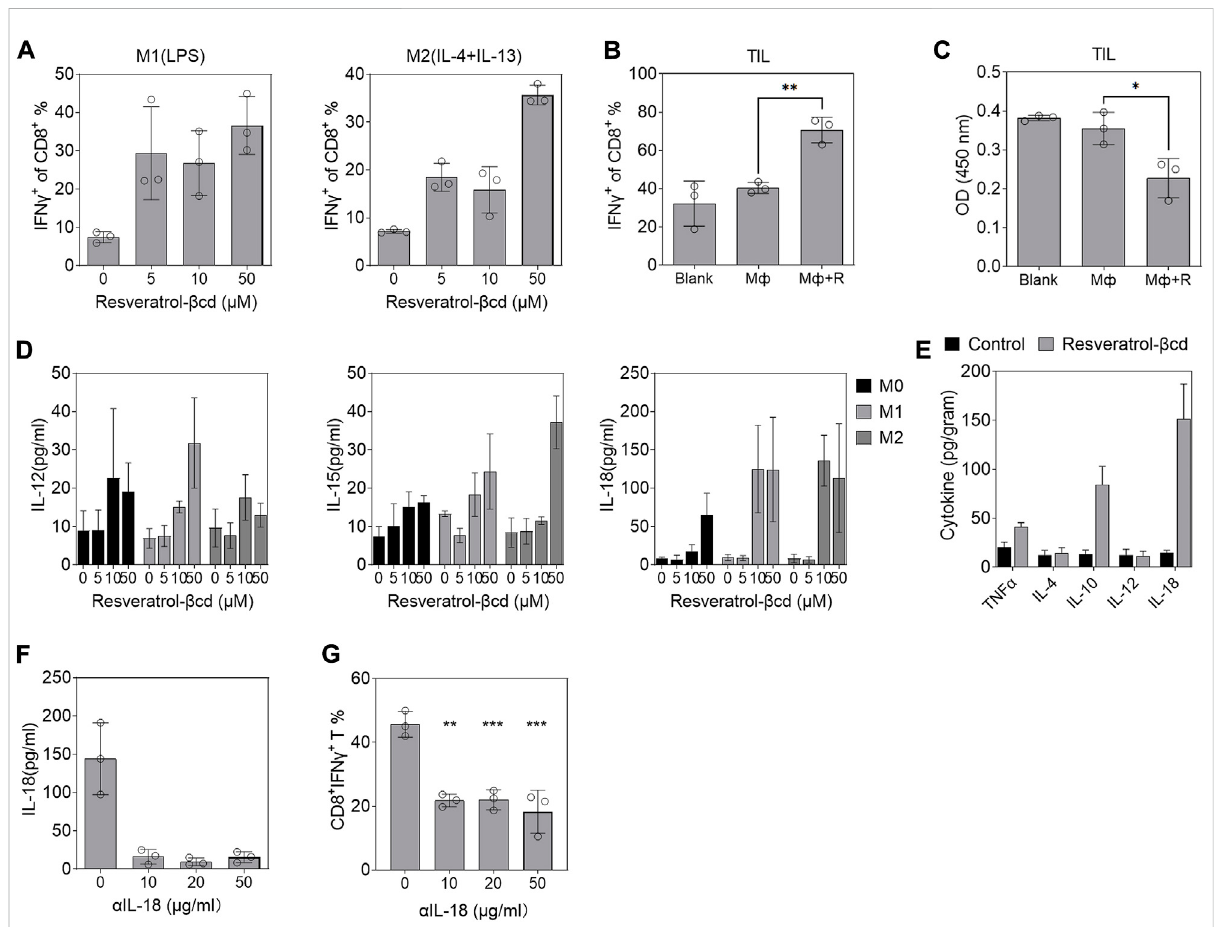
FIGURE 4 Resveratrol- β cdinducedmacrophagestosecreteIL-18andpromoteCD8Tbystanderactivation. (A) CD8Tactivationinco-culturedRaw264.7- derived M1 or M2 macrophages with the indicated resveratrol- β cd and CD8T cells derived from the spleen. Error bar = mean ± S.D. (B) Activation of tumor-derived CD8T cells and cell proliferation (C) in co-culture with M1 macrophages or M1 macrophages + resveratrol- β cd. Error bar = mean ± S.D. (D) M1orM2macrophageswereactivatedandincubatedwiththeindicatedresveratrol- β cdconcentrationsfor48 h.ThelevelsofIL-12,IL- 15, and IL-18 in the supernatant were analyzed by ELISA. (E) Subcutaneous tumors were harvested 4 days after the fi rst treatment. The intratumoral cytokine levels were measured by ELISA. n = 5. Error bar = mean ± S.D. (F) IL-18 in the supernatant of M1 macrophages was neutralized by the indicatedanti-IL-18antibody( α IL-18)andtheeffectofneutralizationwasanalyzed.Errorbar=mean±S.D. (G) Afterneutralization,M1macrophages treated with resveratrol- β cd were co-cultured with spleen-derived CD8Ts. CD8T activation was analyzed 24 h after co-culture. Error bar = mean ± S.D., ** p < 0.01, *** p <